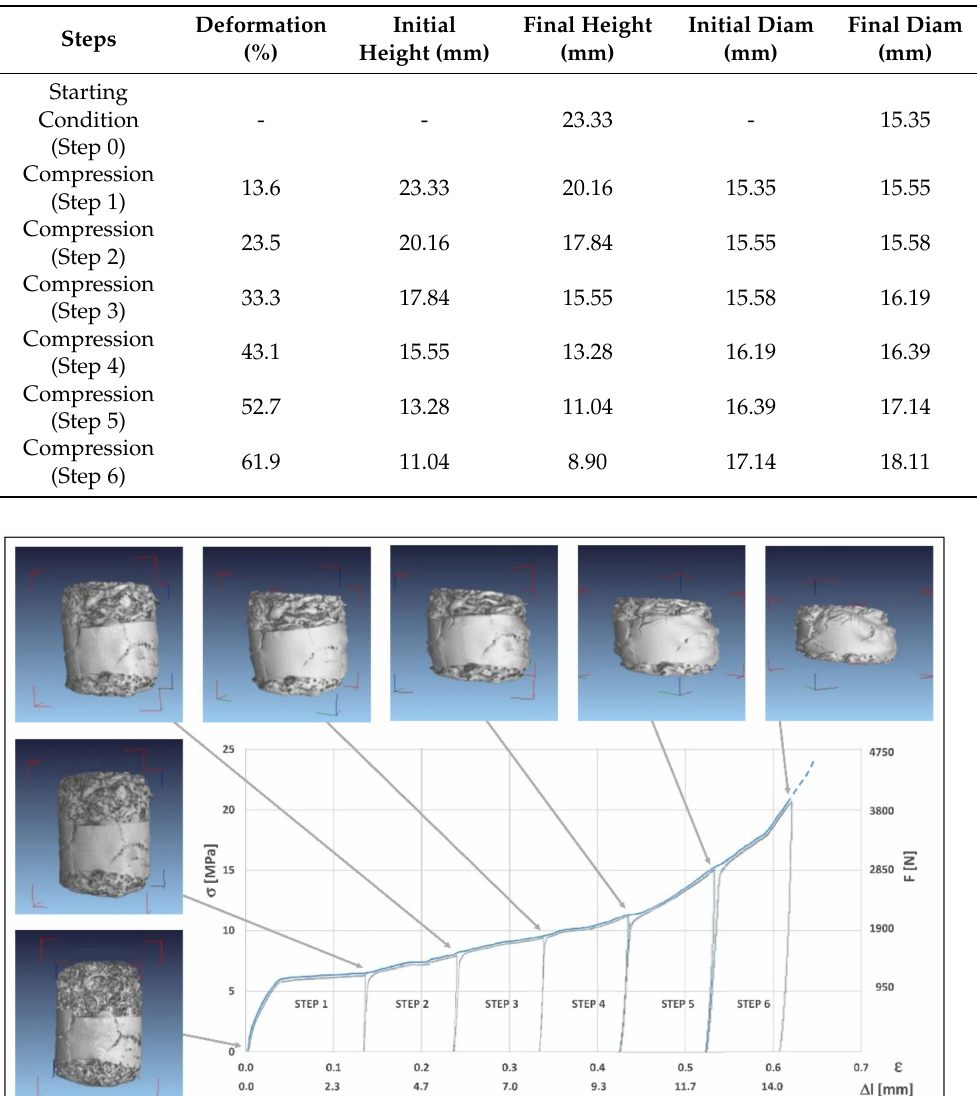
Table 1. Specimen geometric data at compression states (0.4% TiH 2 foam).